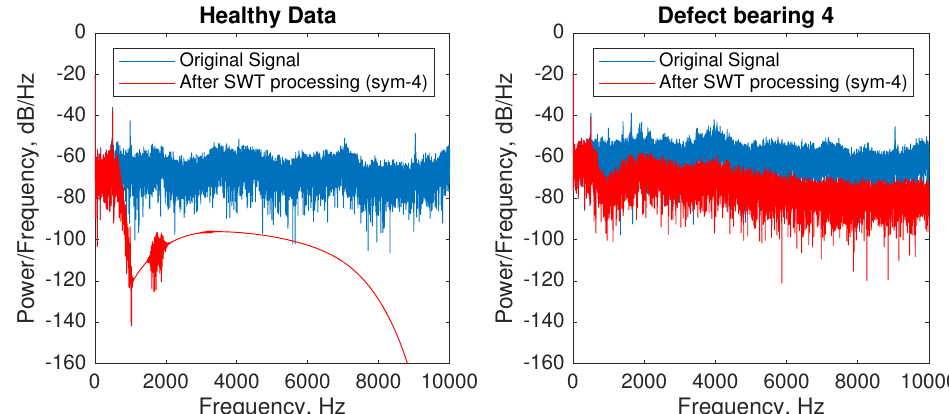
Figure 4. PSD estimate of before and after denoising using Stationary Wavelet Transform.